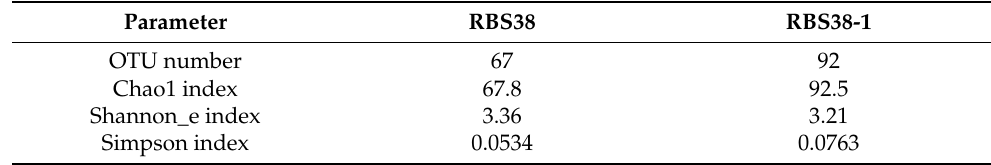
Table 1. Diversity of prokaryotes in microbial communities of RBS38 and